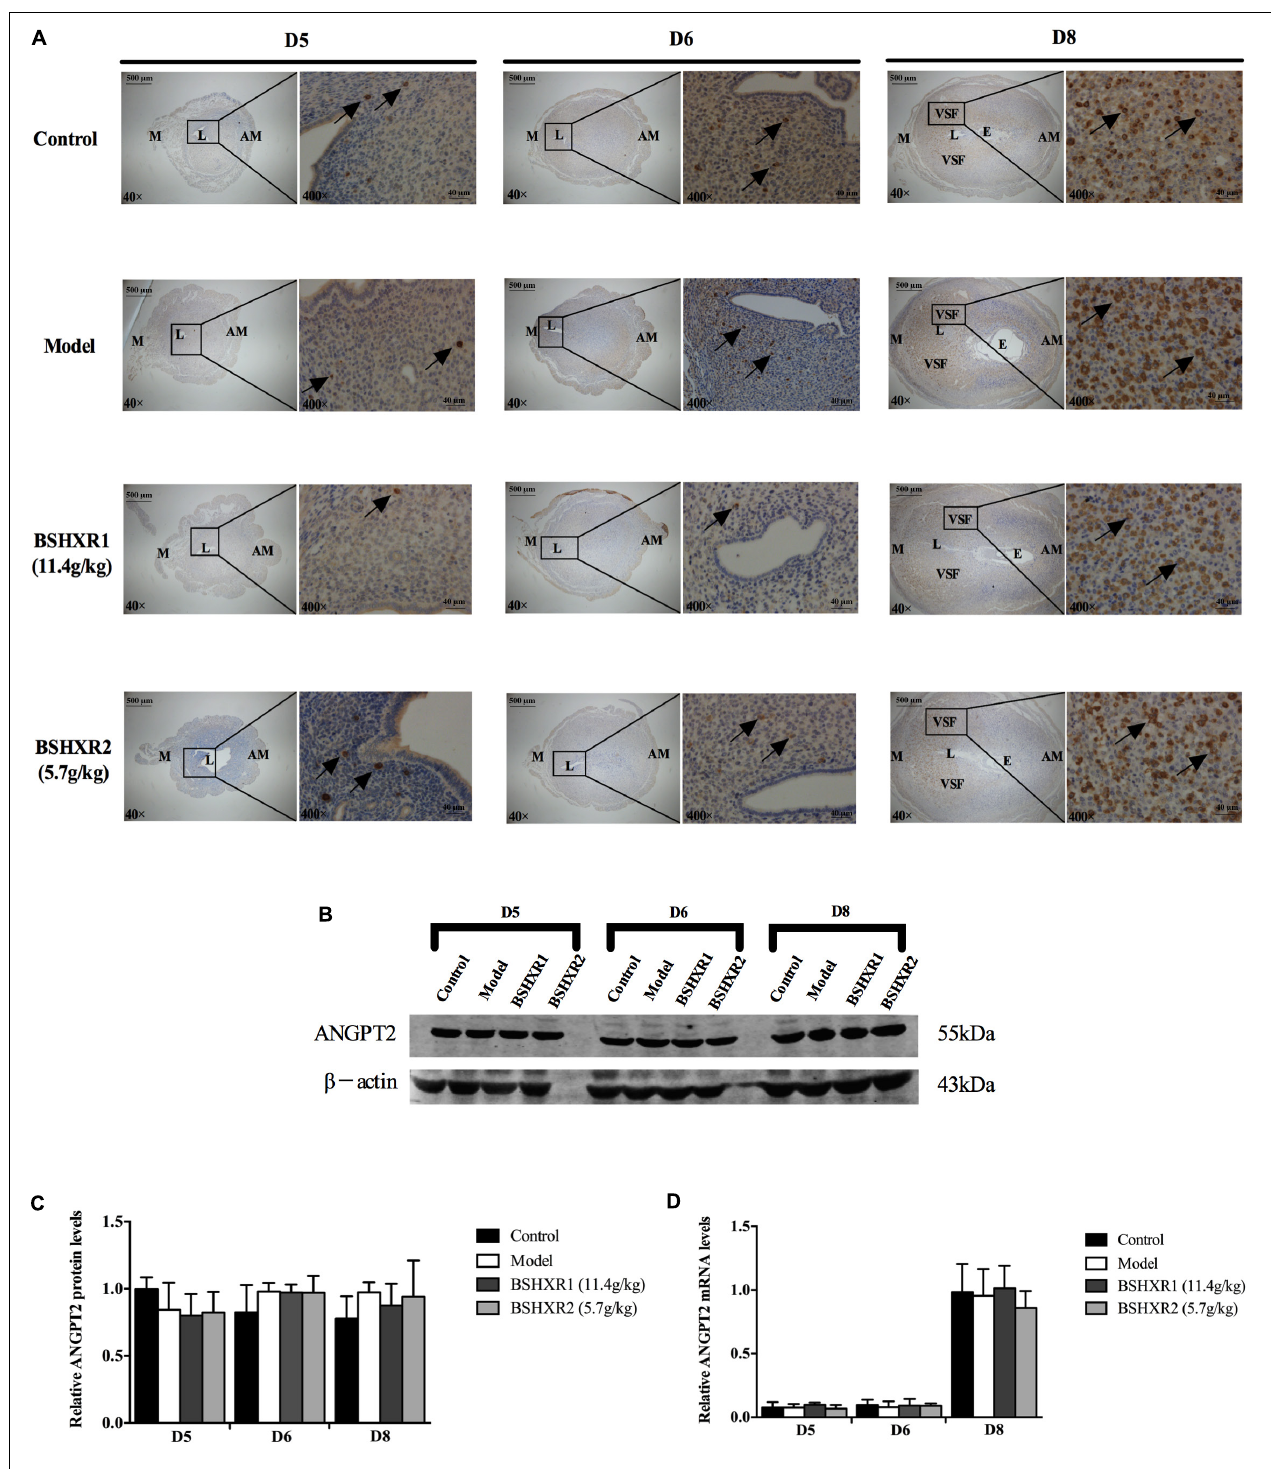
FIGURE 10 | ANGPT2 expression in the uterus on D5, D6, and D8. (A) Immunohistochemistry of ANGPT2 in paraffin sections of the uterus. The right pictures are the higher magnification images of the black boxes on the left. Arrow indicates the positive staining. L, lumen; E, embryo; M, mesometrial; AM, anti-mesometrial; VSF, vascular sinus folding. Original magnification and scale bar were shown in the pictures. (B) Protein levels of ANGPT2 in pregnant uterus (remove embryo) by western blot analysis ( n = 3). (C) Quantification of ANGPT2 protein expression. (D) mRNA levels of ANGPT2 in pregnant uterus (remove embryo) by qRT-PCR ( n = 5). Data represent mean ± SD. β -actin was used as the